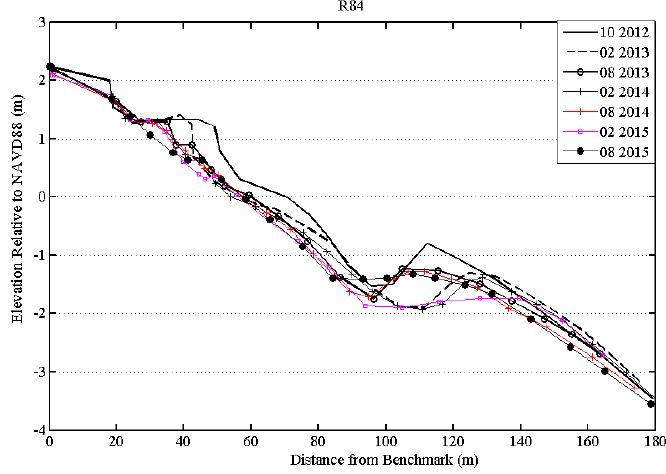
Figure 8. Example profile from the Headland, R84.